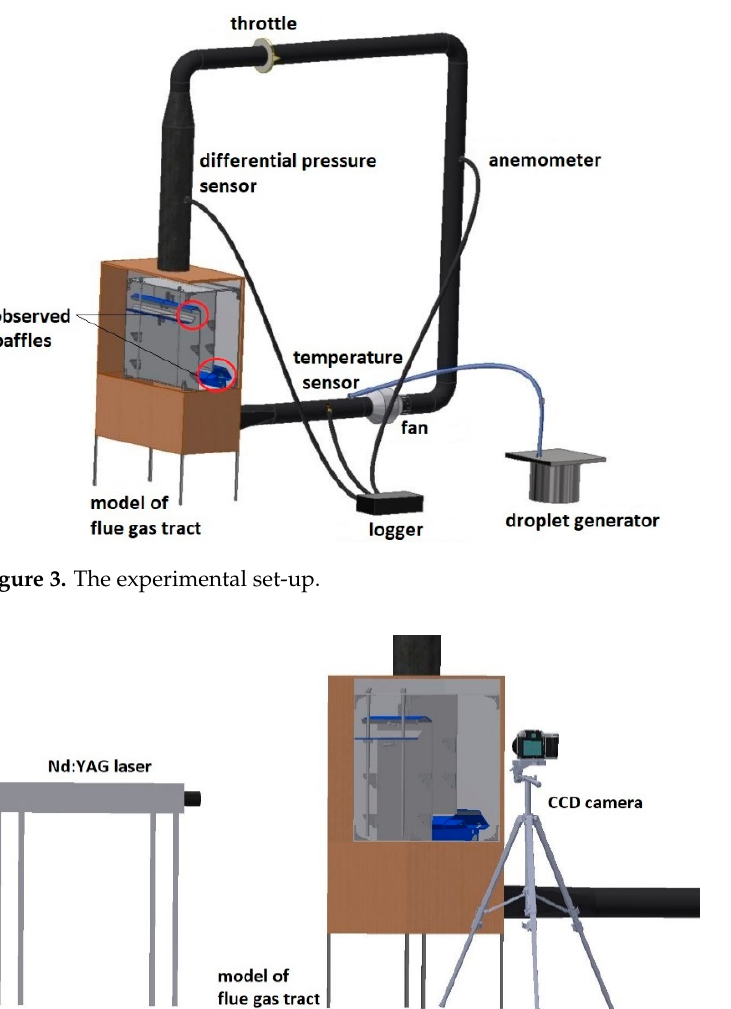
Figure 4. PIV equipment.